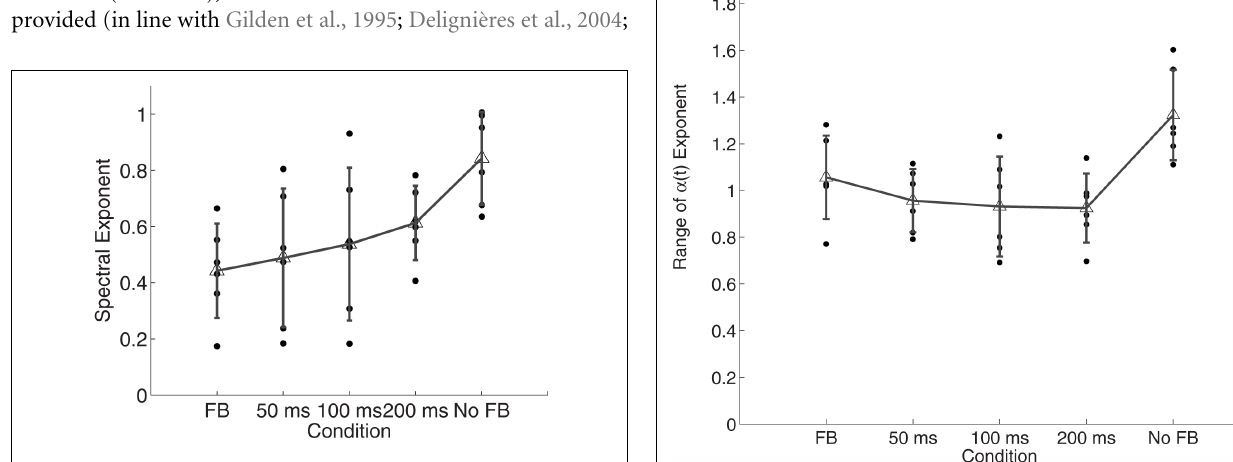
FIGURE 3 | Spectral exponents of the time estimates. Spectral exponents α closer to 0 imply presence of white noise whereas values closer to 1 suggest pink noise. Individual points represent observations from individual participants. Error bars plot within-condition SD.